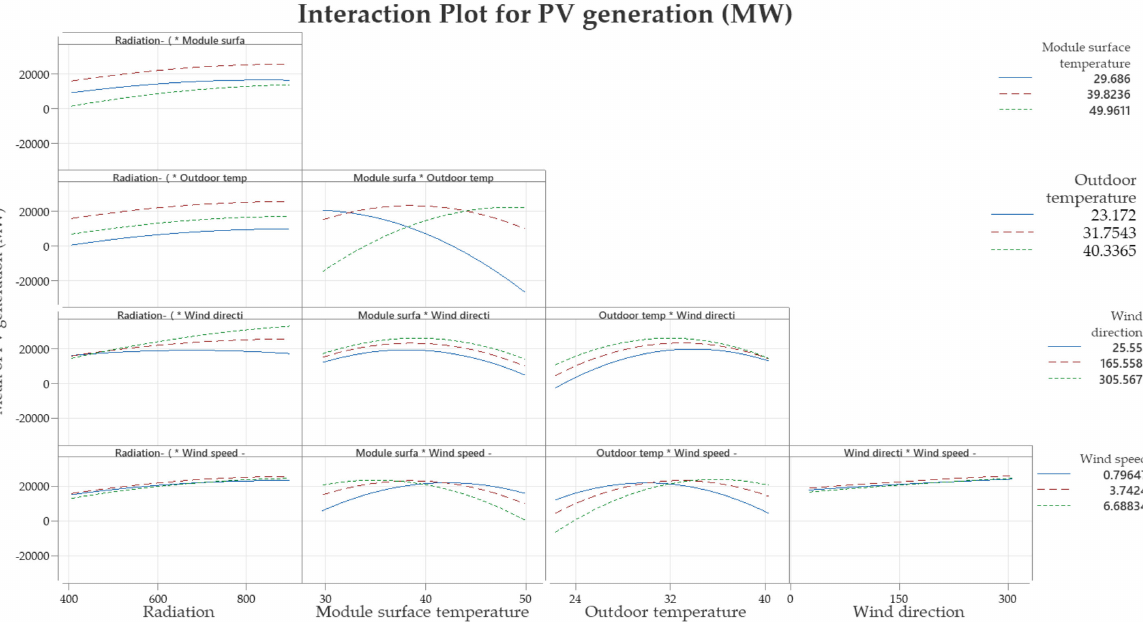
Figure 16. The contour plot of solar PV generation versus wind speed and outdoor temperature ( a ) and wind speed and radiation ( b ). The three-dimensional graph of solar PV energy generation versus wind speed, outdoor temperature ( c ), and wind speed radiation ( d ).